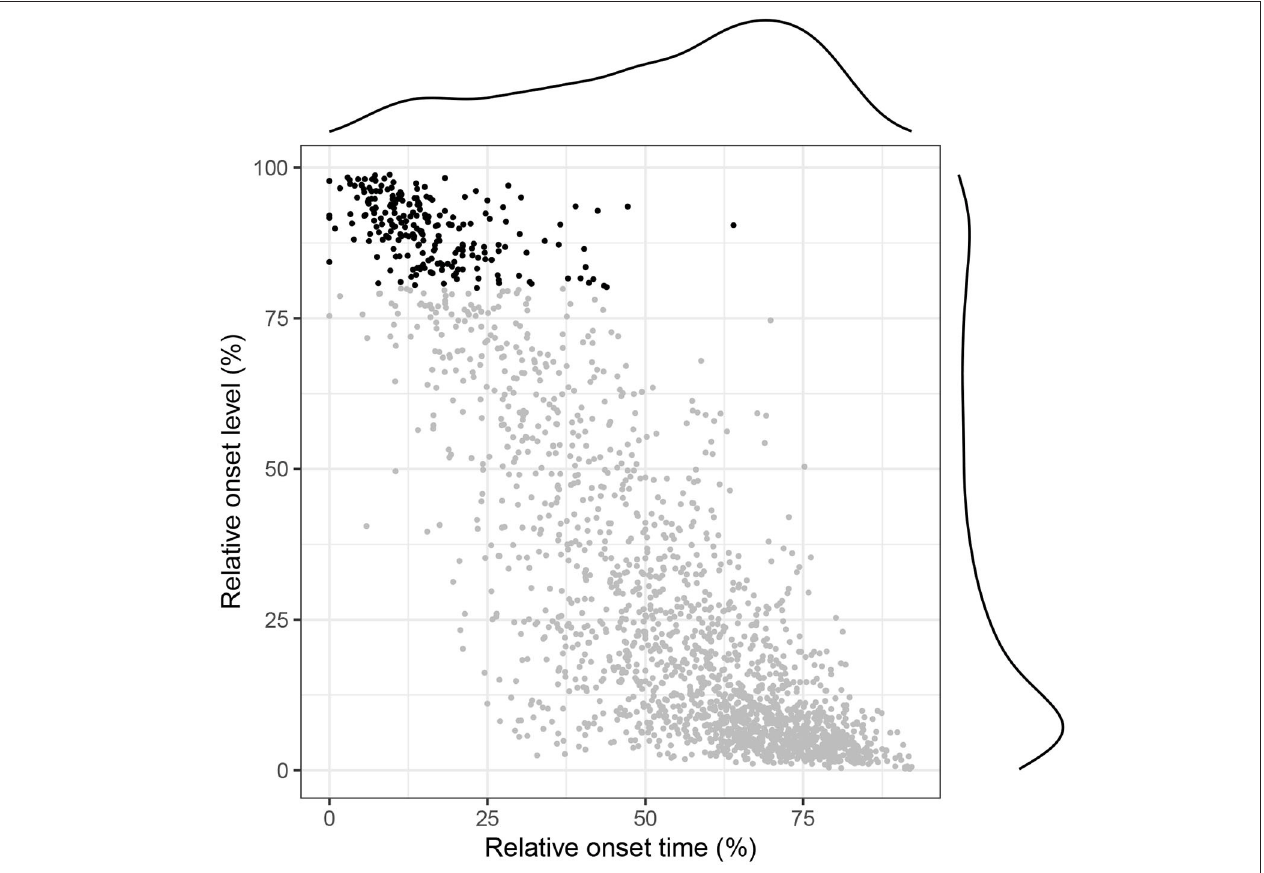
FIGURE 7 | Distribution of holds within the exhalation in silent breathing. Holds occurring in the top 20% of the exhalation amplitude are plotted in